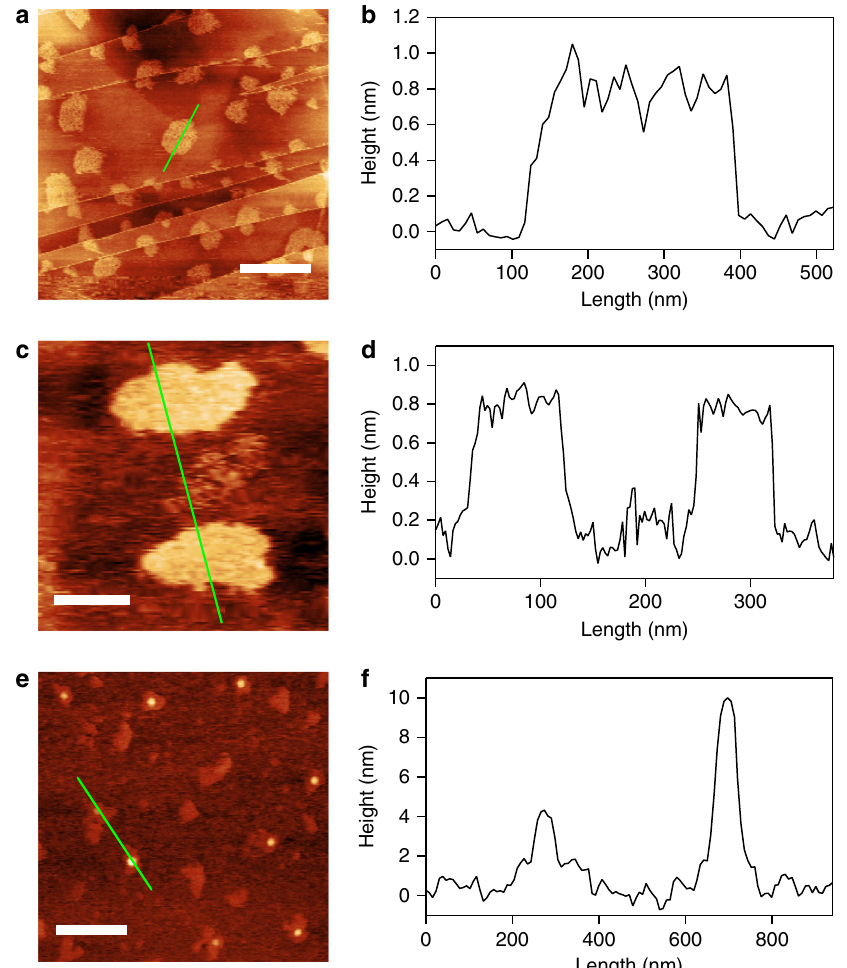
Fig. 4 AFM images of PSt-1 deposited on HOPG or mica substrates. a AFM topographic image and b height pro fi le of PSt- 1 deposited on an HOPG substrate. Scale bar: 500 nm. c A magni fi ed AFM topographic image and d height pro fi le of independent sheets of PSt- 1 deposited on an HOPG substrate. Scale bar: 100 nm. e AFM topographic image and f height pro fi le of PSt- 1 deposited on a mica substrate. Scale bar: 500 nm. Each height pro fi le follows the green line in the corresponding AFM image. All materials were spin-cast on the given substrate from a 0.1 µ g mL – 1 chloroform